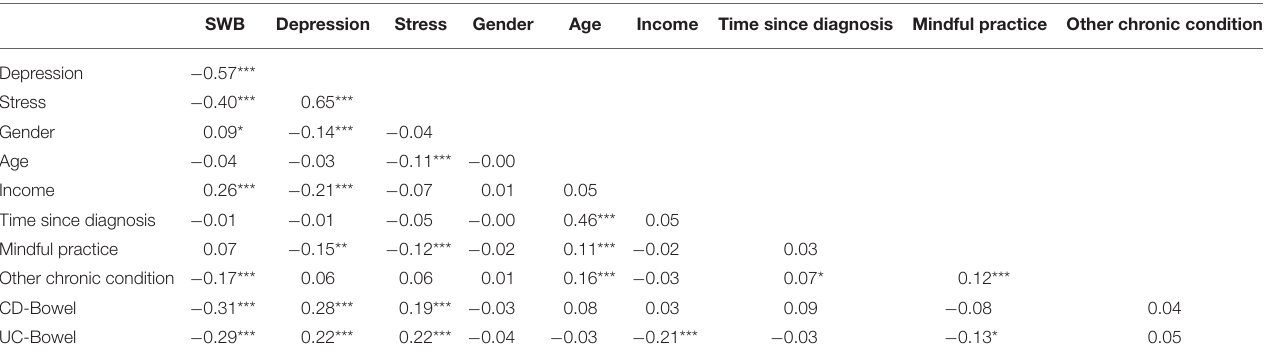
TABLE 3 | Spearman’s correlation matrix showing relationships between psychological, disease, demographic and mindfulness characteristics.